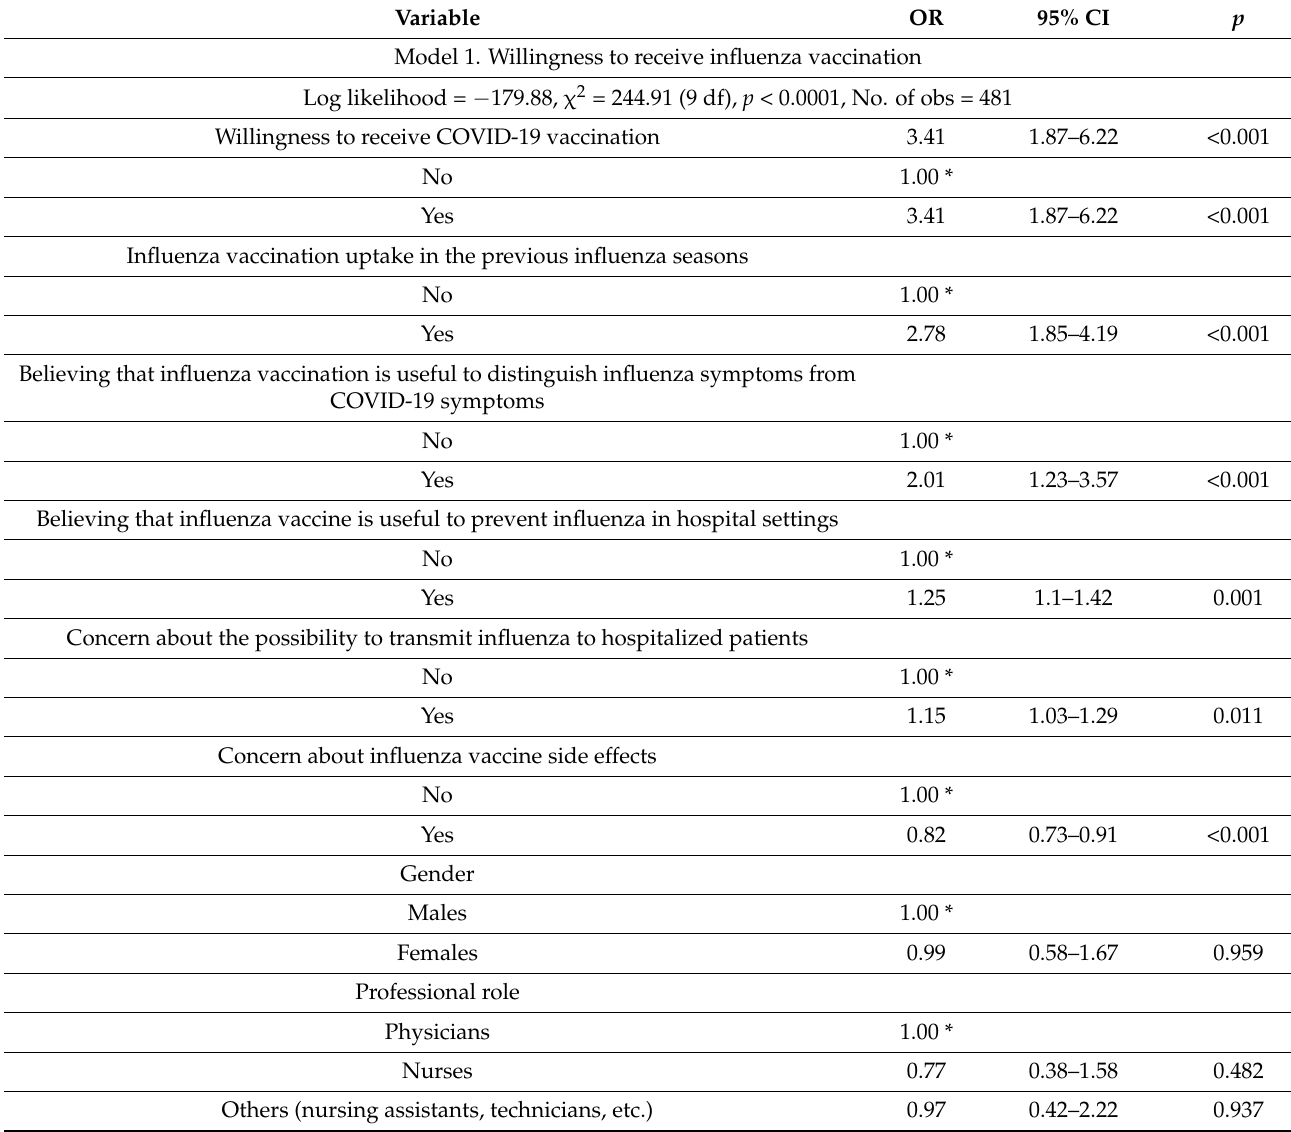
Table 3. Multiple logistic regression analysis about willingness to receive the influenza vaccination according to several explanatory